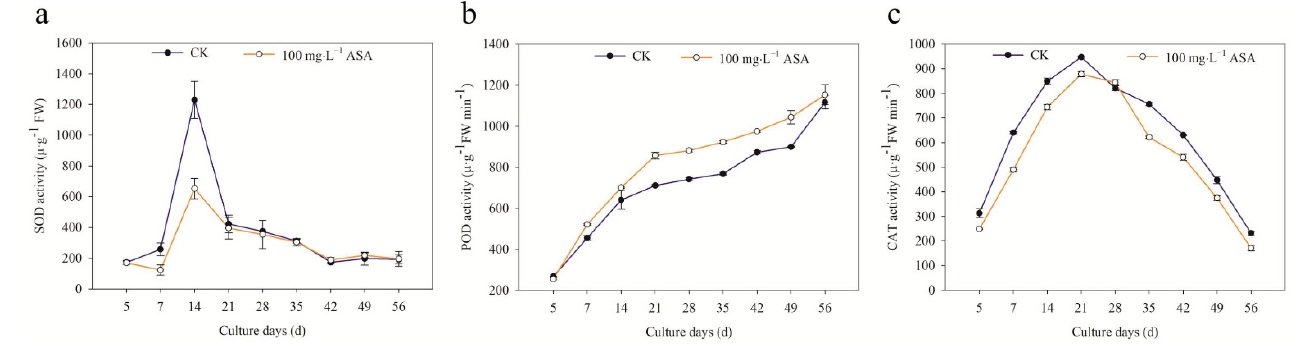
Figure 4. Effects of 0 and 100 mg · L − 1 ASA treatments on SOD activity, POD activity, and CAT activity during somatic embryogenesis of Fraxinus mandshurica provenance 3. The x -axis represents the culturing days, and the y -axis represents the SOD activity ( a ), POD activity ( b ), and CAT activity ( c ). Error bars show the standard error of the mean.